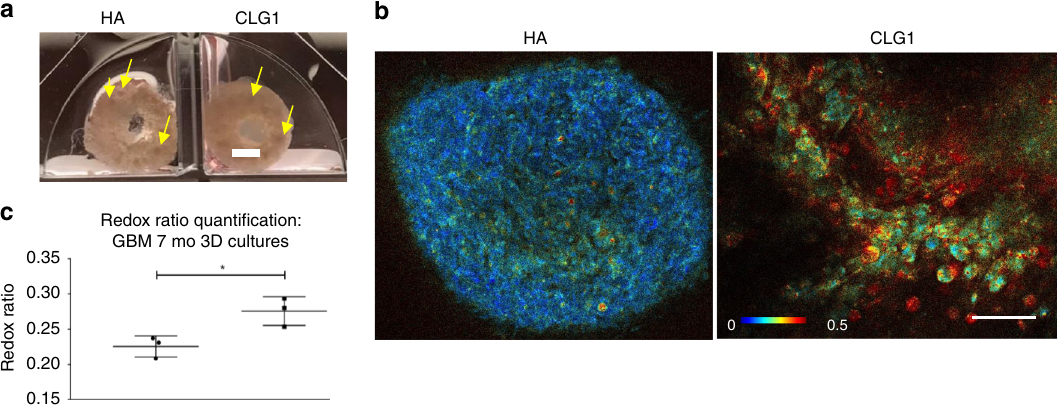
Fig. 6 Live metabolic imaging of glioblastoma cultured in 3D silk-CLG1 or silk-HA constructs. a Macroscopic views of the GBM spheres within silk-CLG1 or silk-HA constructs. Scale bar, 2 mm. The yellow arrows point at spontaneously forming sphere-like structures from the seeded tumor cells post dissociation. b Representative redox ratio images from endogenous metabolic co-factors FAD and NADH within GBM cells in 3D constructs at 1.5 mo post-gel addition and 7 mo post cell seeding. Scale bar, 50 µ m. Image heatmap re fl ects varying redox ratio intensities. c Quantitative intracellular signal evaluation validated the existence of metabolic differences between HA and CLG1 conditions, with a statistically signi fi cantly higher redox ratio (FAD/FAD + NADH) in CLG1 cultures. Unpaired two-tailed t -test, p = 0.0271, df = 4, t = 3.406, n = 3 per condition (Multiple areas imaged per condition = 3 – 8; total imaged in CLG1 = 13, HA = 19). Error bars indicate mean± s.d, Source data are provided as a Source Data fi